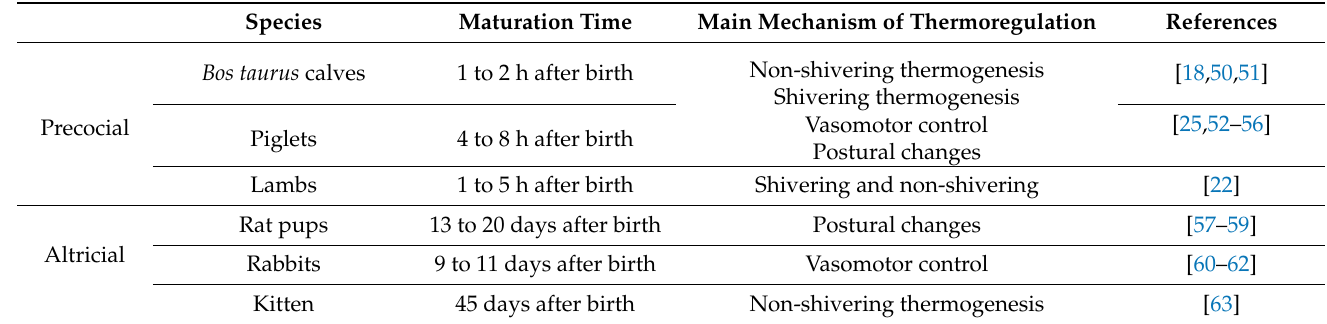
Table 1. Main mechanism of thermoregulation and its maturation time in different species. The difference between altricial and precocial species depends on the degree of neurodevelopment which can produce variations in time to achieve optimal thermoregulation between them. Precocial species reach this capacity in the first hours after birth, while altricial species develop this ability between 20 and 45 days after